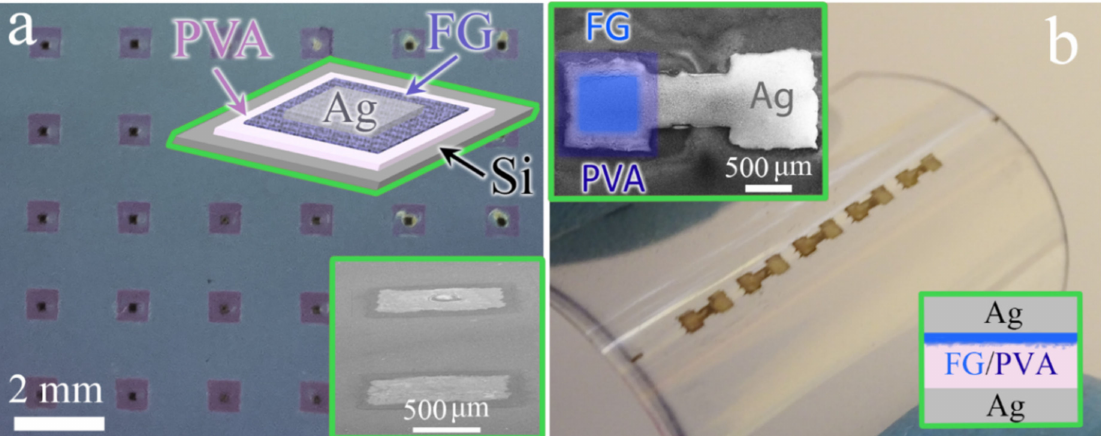
Figure 1. ( a ) SEM images of the two crossbar memristor structure variants and, in the insert, the sketch of the crossbar memristor structures. ( b ) Optical photo of the 2D printed crossbar memristor structures array on PET without top Ag contact to the active FG–PVA layer of one of the structures. The insert shows the SEM image of the one structure with a colored active FG–PVA layer. The active layer size is 900 × 900 µ m, and the Ag contact size is 300 × 300 µ m. The crossbar memristor structures are given in the